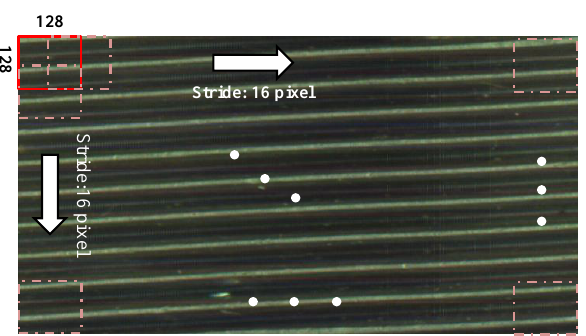
Figure 9. The slice patches of the panoramic screw image for the training phase (unit: 0.03 mm/pixel).